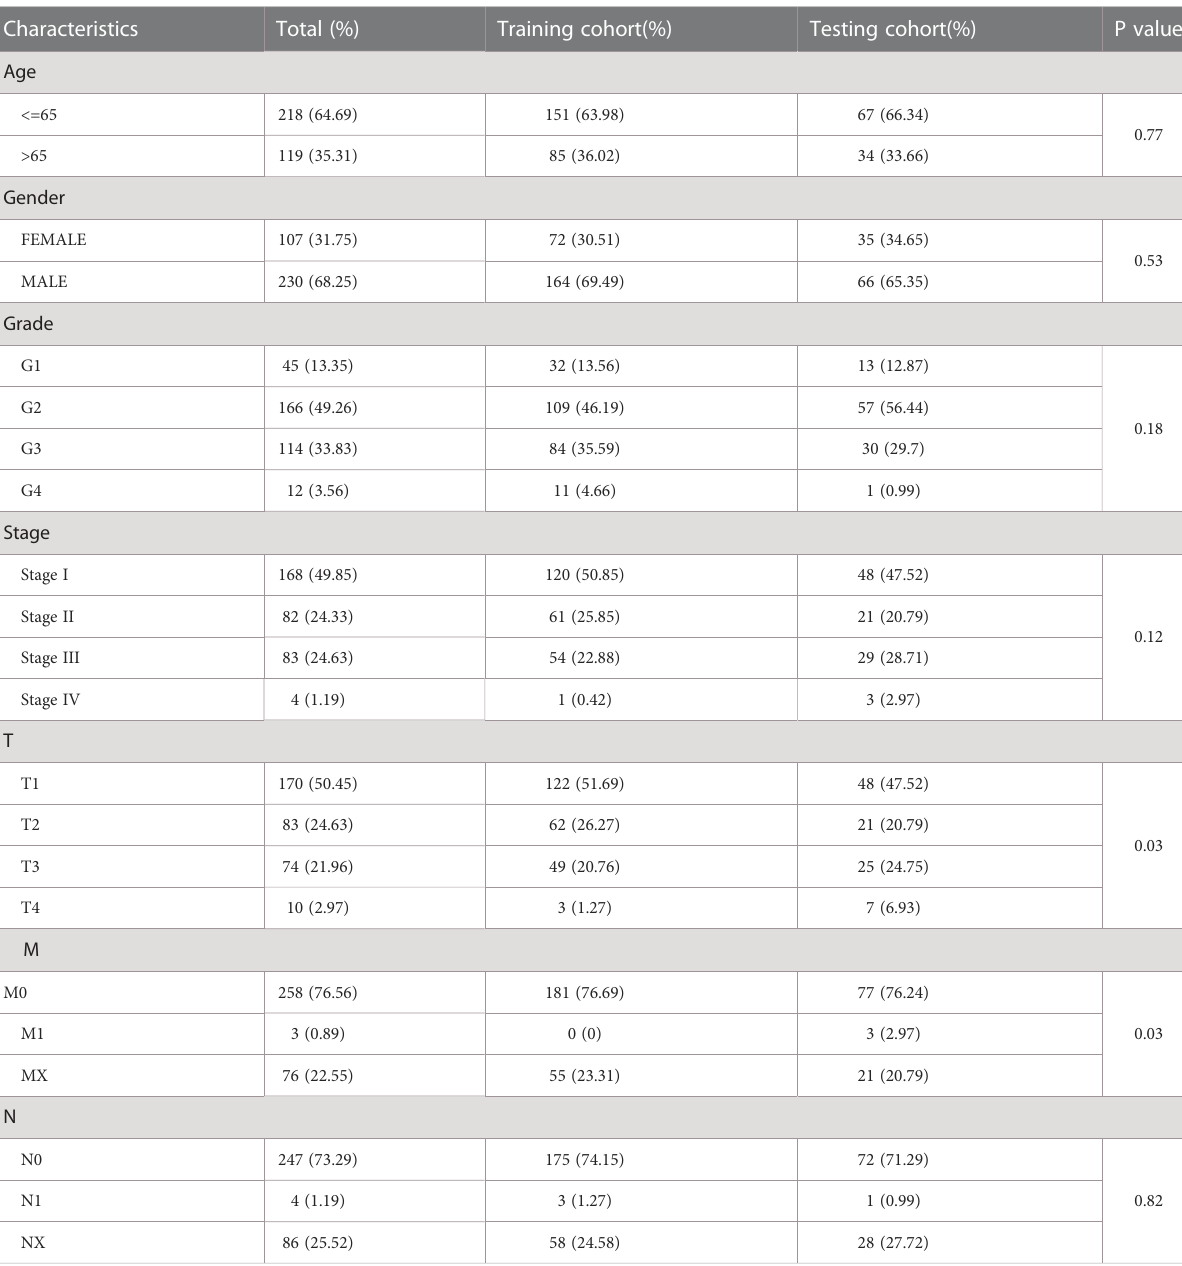
TABLE 1 The Clinicopathological Characteristics in Training and Testing